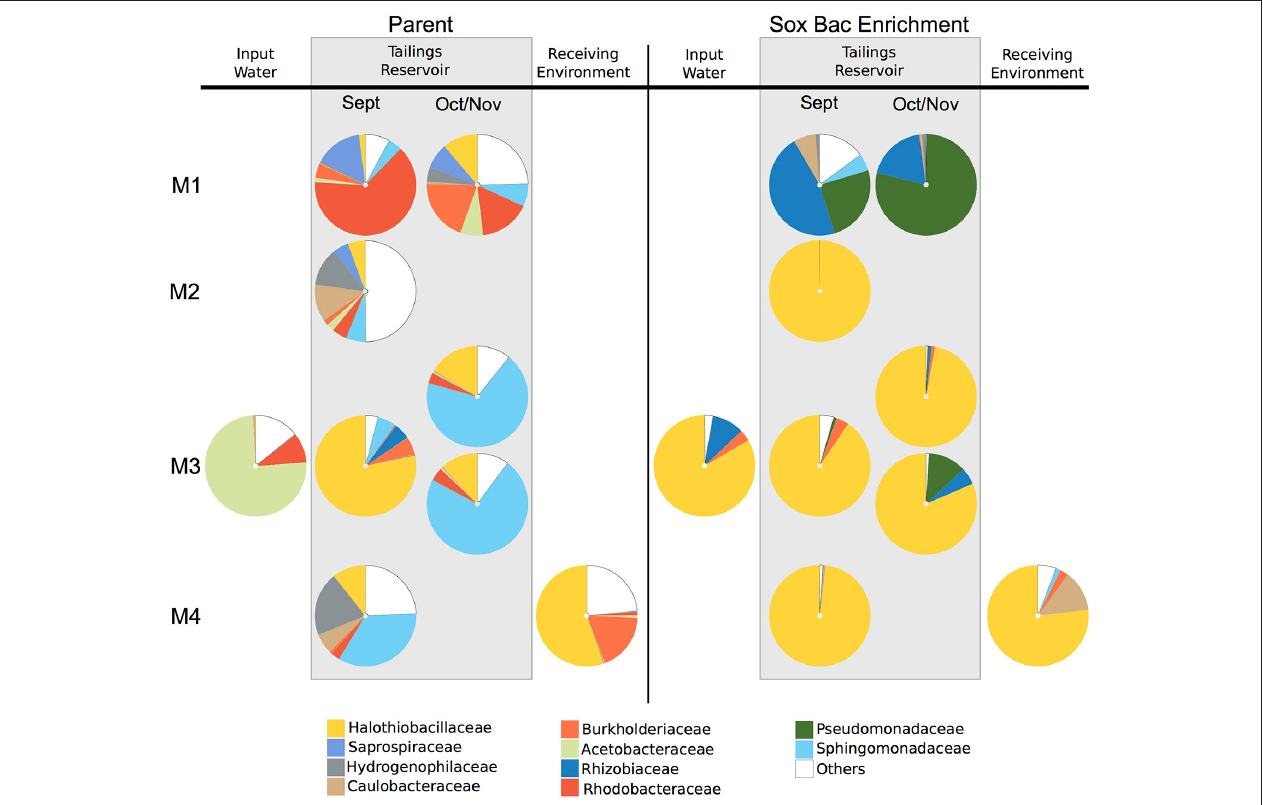
FIGURE 1 | Relative sequence abundance of bacterial families across mine environments. Sequences were obtained by Illumina sequencing of 16S rRNA gene amplicons (A) in parent communities ( n = 9) of mining wastewater at Mine 1 (M1) [Tailings reservoirs (0.5m) in September and October], Mine 2 (M2) [Tailings reservoir (0.5m) in September], Mine 3 (M3) [Tailings reservoir (2m) in September, Input water, and Tailings Reservoir (0.5m and 10m) in November], and Mine 4 (M4) [Tailings reservoir (7m) and Receiving Environment in September] and (B) the communities grown through sulfur oxidizing bacterial (SoxBac) enrichment experiments ( n = 9). “Others” is defined as organisms that had lower relative abundance than the 10 bacterial families with the highest proportions across all samples.